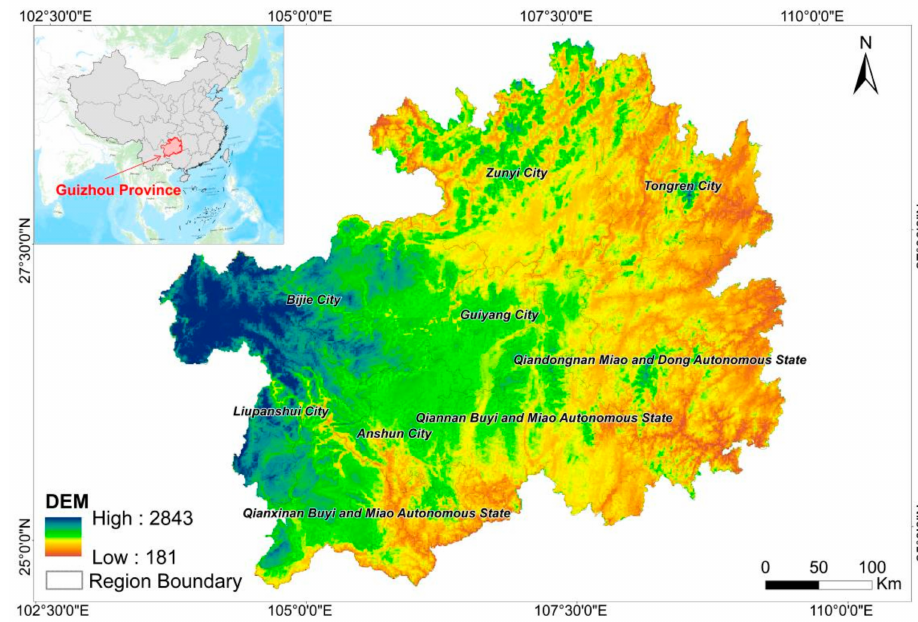
Figure 1. Overview map of the study